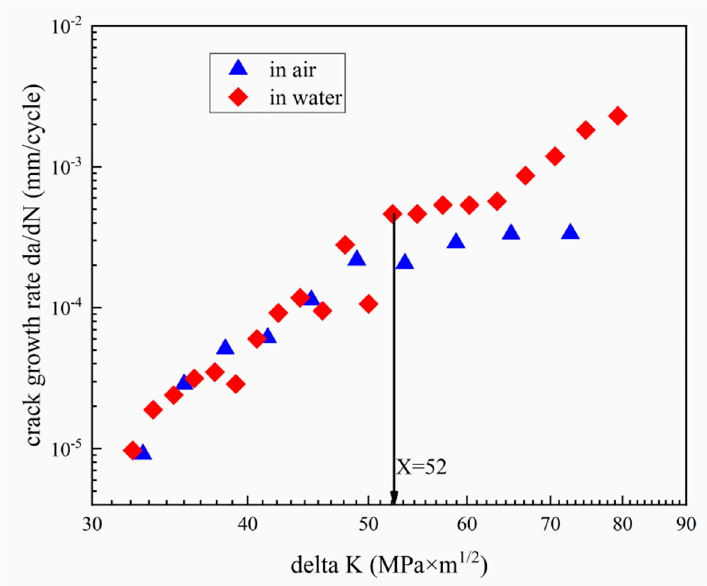
Figure 7. The diagram of the fatigue crack growth rate of X80 steel welded joints in the air and water conditions.